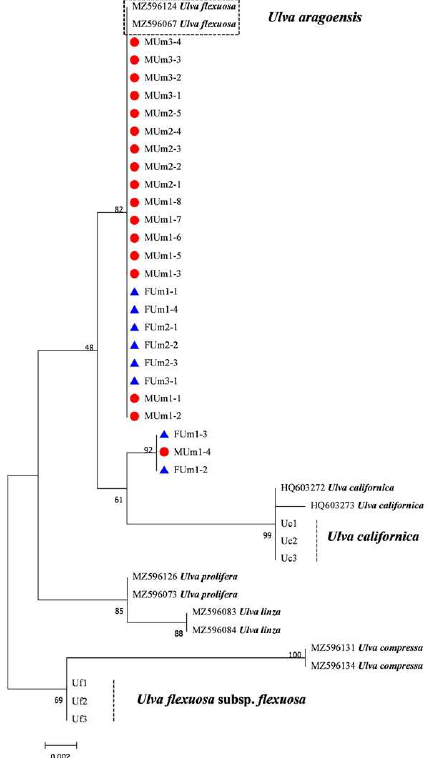
Figure 11. Maximum likelihood tree constructed from the analysis of large subunit gene sequences of U. aragoensis samples and those downloaded from GenBank.